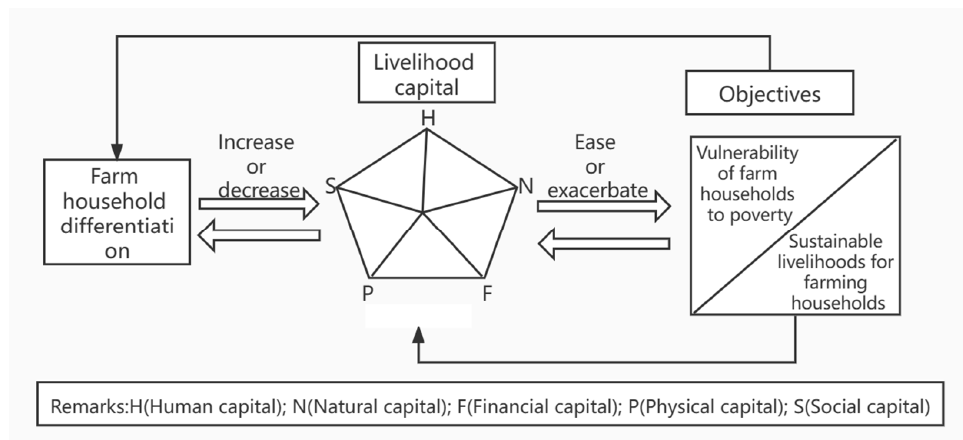
Figure 1. Mechanisms of farm household differentiation, poverty vulnerability, and sustainable livelihood formation.